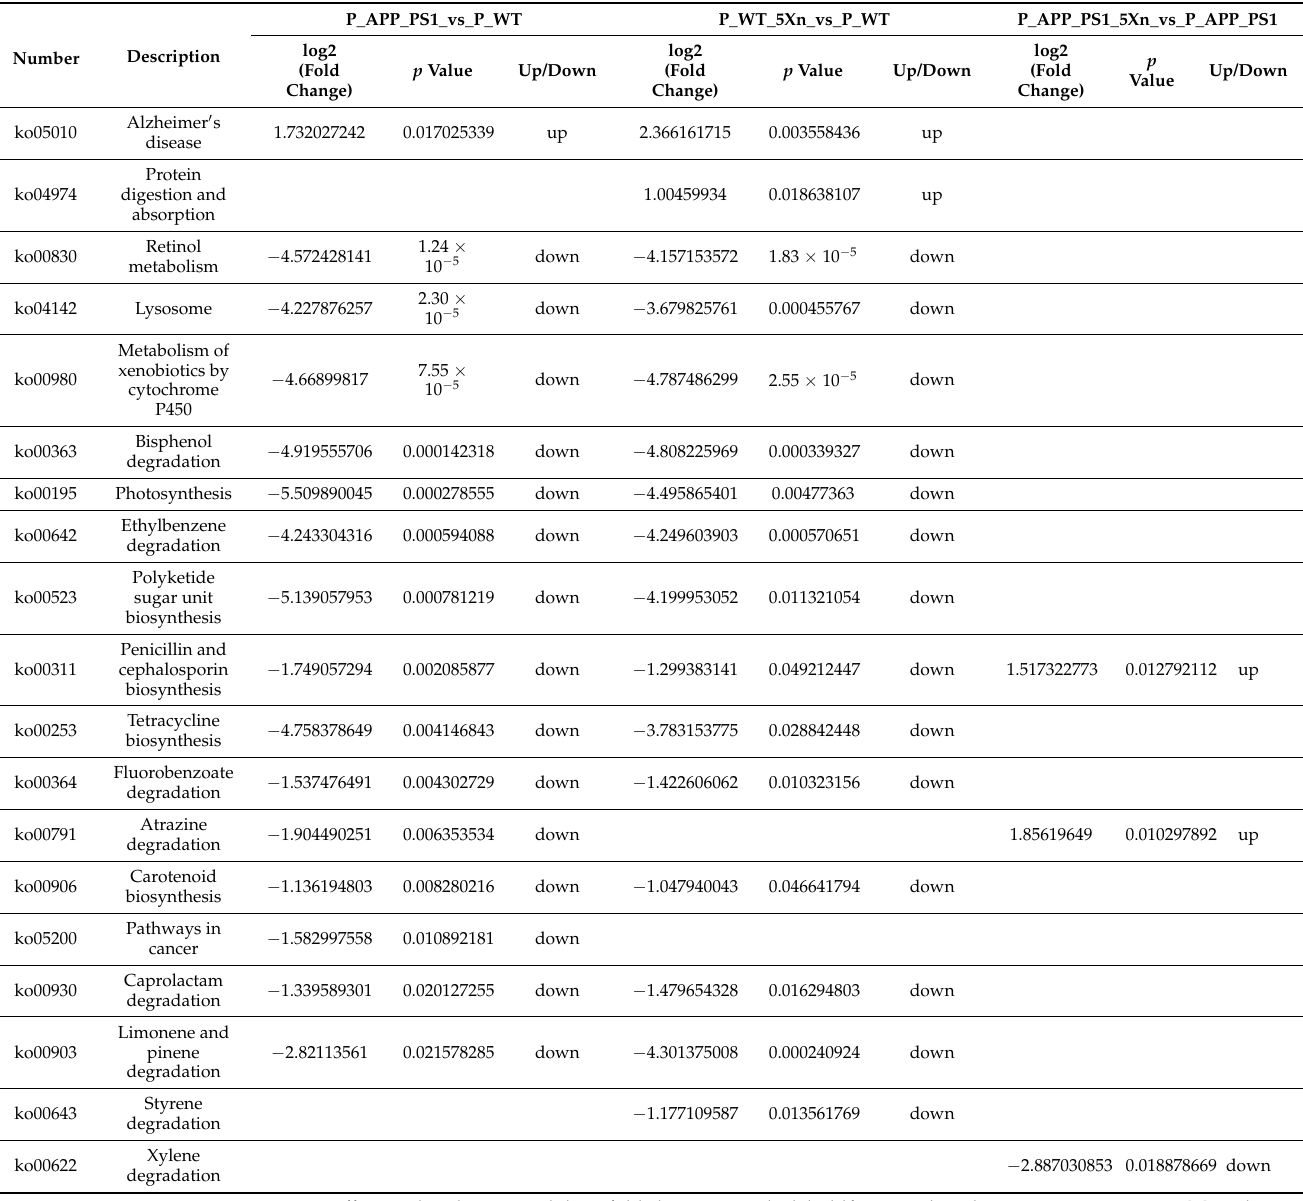
Table 1. Differential KEGG pathways predicted via PICRUSt software in the Xn prevention experiment.